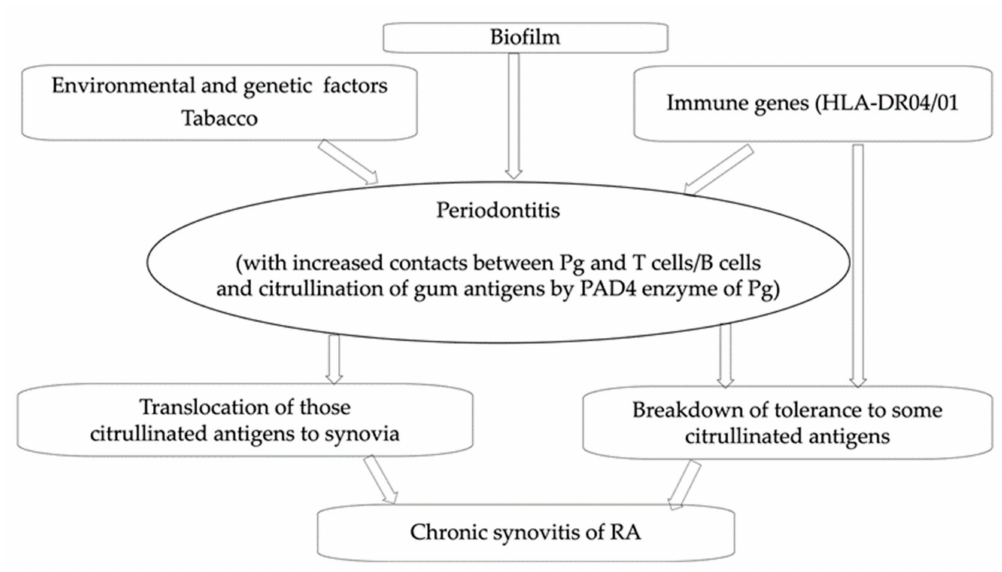
Figure 1. Former hypothesis of contribution of oral bacteria to RA pathogenesis. Table 1. Clues suggesting a contribution of oral–gingival microbiota to the contribution of rheumatoid